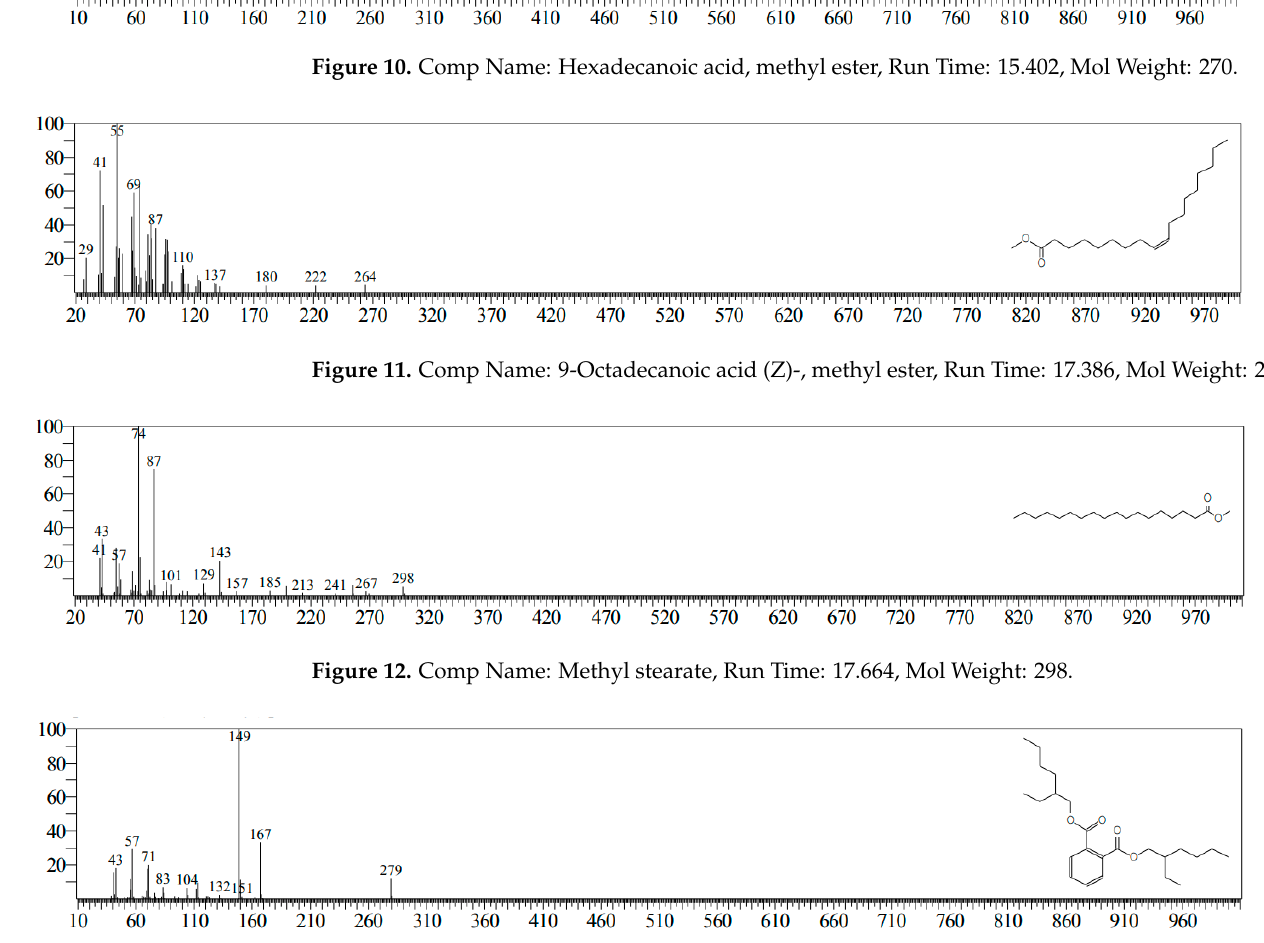
Figure 13. Comp Name: Bis(2-ethylhexyl) phthalate, Run Time: 21.973, Mol Weight: 390.